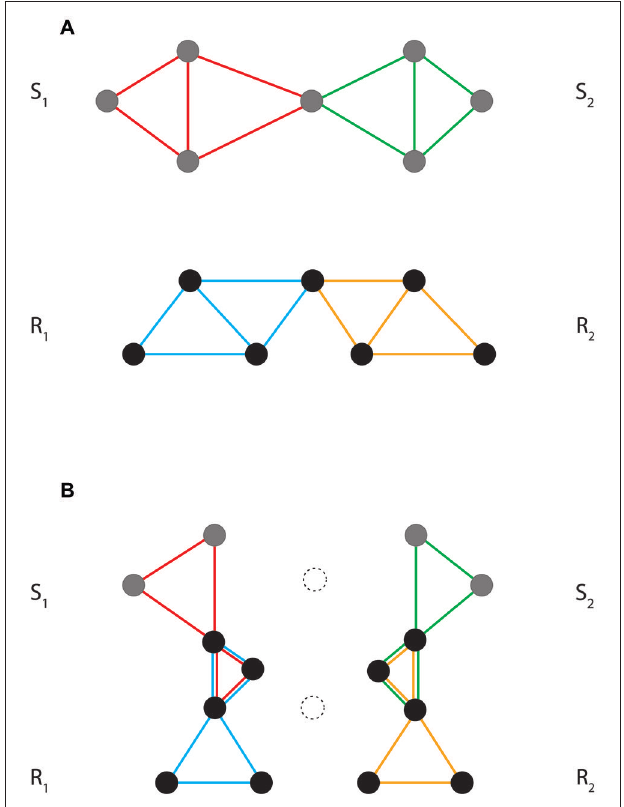
FIGURE 3 | Interactions between event codes in task set formation. (A) Initial structure of a hypothetical event code assembly, with two partially overlapping stimulus codes (S 1 /S 2 ) and two partially overlapping response codes (R 1 /R 2 ). (B) Final structure of the same assembly, with initial horizontal overlap among stimulus and response codes deleted (unconnected dotted features) and new vertical overlap between stimulus and response codes created. Note that the final structure of the assembly differentiates between wanted and unwanted S-R assignments (wanted: S 1 –R 1 and S 2 –R 2 ; unwanted: S 1 –R 2 and S 2 –R 1 ). To illustrate, consider a task requiring left key presses in response to squares (S 1 → R 1 ) and right key presses in response to circles (S 2 → R 2 ). An efficient task set must, on the one hand, weaken, or delete features that are shared among the competing stimuli and the competing responses (like, e.g., the closedness of the two shapes and the downward-directed push of the two key presses, respectively). On the other hand, it must implement the required mappings by creating overlap between distinctive features of stimuli and responses (such as, e.g., straight lines/left key vs. curved lines/right key ) and creating new functional features instantiating these